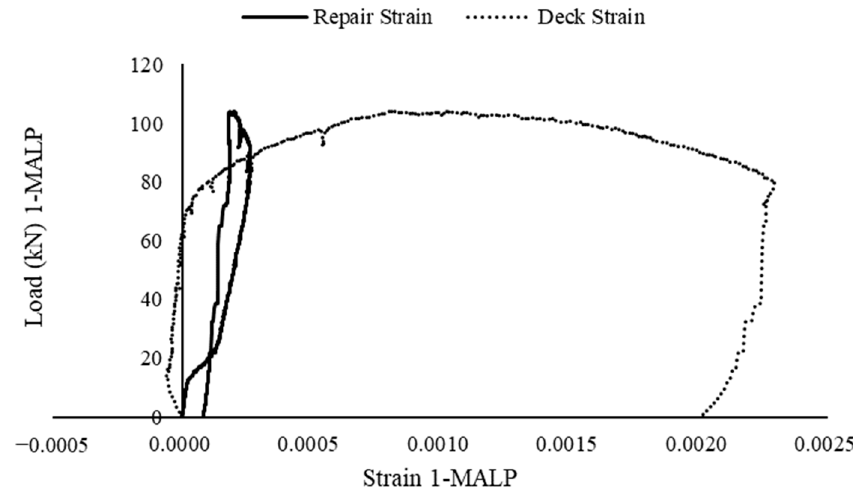
Figure 10. 1-MALP load vs. strain for each instrumented reinforcing bar.